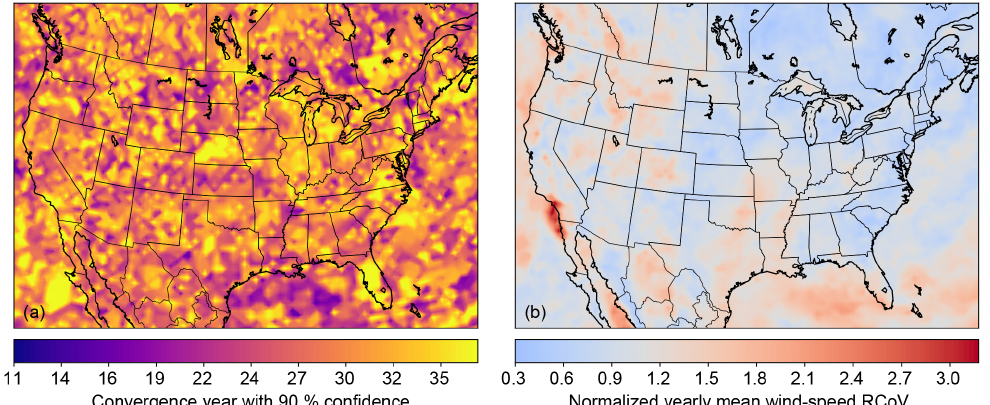
Figure A3. As in Fig. 10a and b, but the data plotted are annual-mean wind speeds: (a) map of the convergence years, or years of wind-speed data required to derive a maximum of 10% deviation from the 37-year RCoV at each grid point at a 90% confidence level. Because 12.6% of the CONUS grid points yield convergence years beyond 37 years using annual data (solid orange line in Fig. 9 and first column in Table B5), we assign 37 years as the convergence years for those grid points. After excluding the non-numeric values, the CONUS median is 27 years and the MAD is 4 years; (b) map of RCoV of annual-mean wind speed using the grid-cell-specific convergence years in (a) , normalized using the CONUS RCoV median at 0.020. The RCoVs illustrated are averaged over (37 − convergence year + 1) available year blocks. The MAD of the normalized RCoV in the CONUS is 0.205.